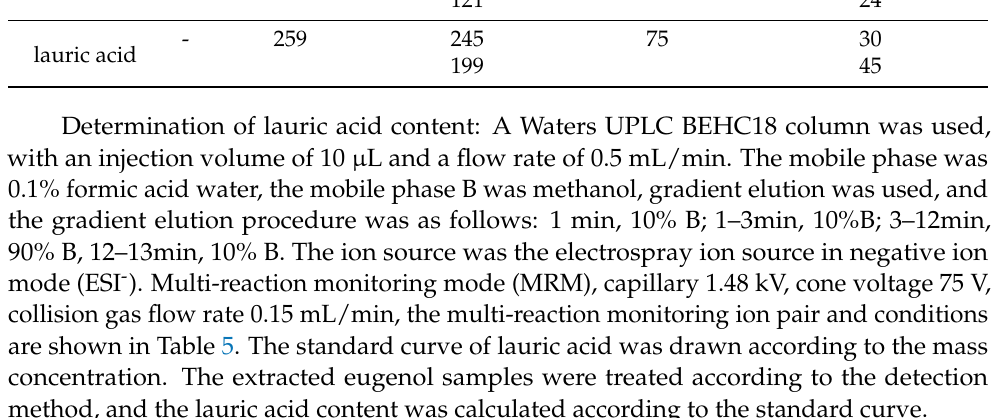
Table 5. MRM ion pairs and mass spectral parameters for eugenol and lauric acid. Compounds ESI Parent (m/z) Daughter (m/z) Cone voltage/V Colision energy/eV